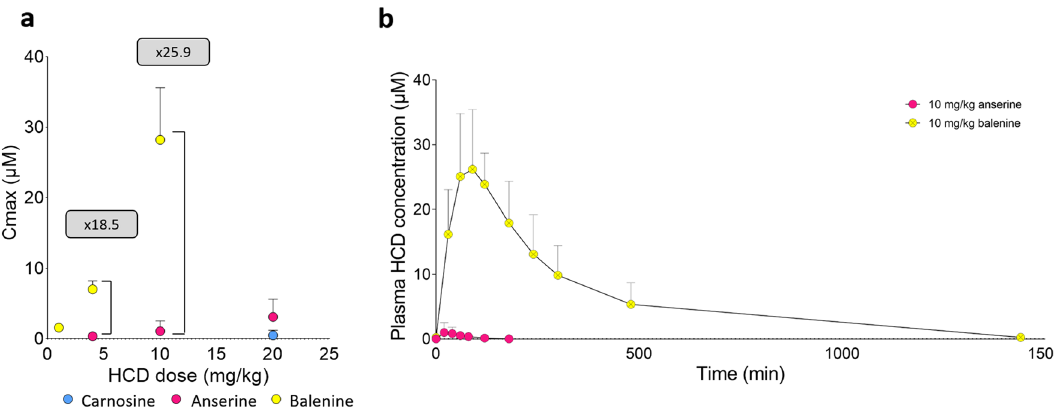
Figure 3. Comparison of Cmax values of carnosine (n = 12) 22 , anserine (n = 7) 20 and balenine (n = 6) according to the doses ingested ( A ). Plasma concentration time profile following ingestion of 10 mg/kg anserine 20 or balenine ( B ). Mean ± SD are